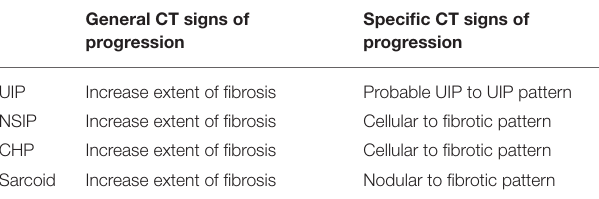
TABLE 1 | Radiology features of progressive fibrotic interstitial lung disease. General CT signs of